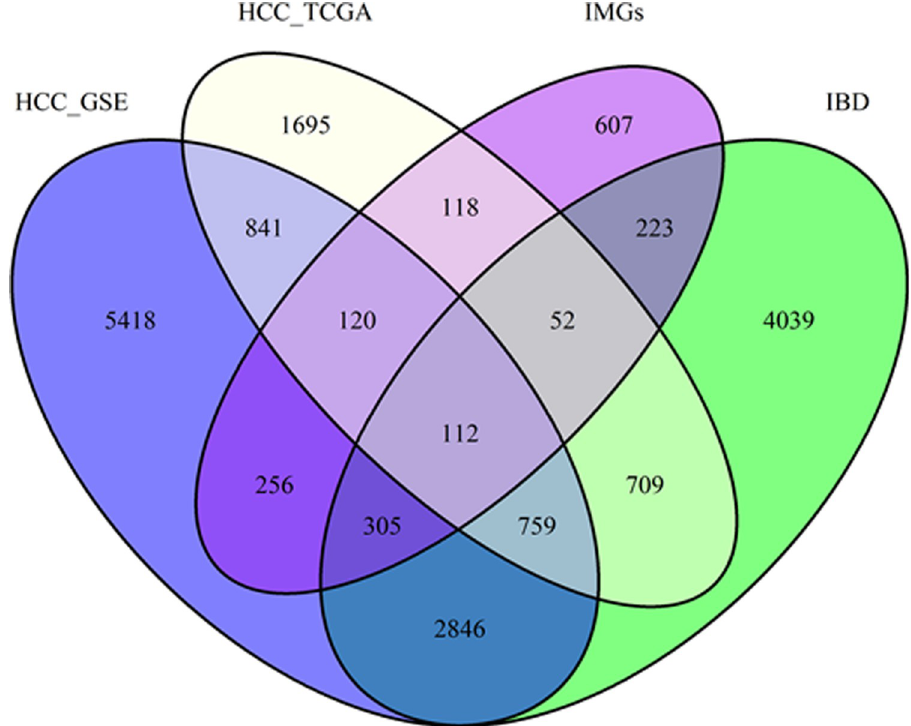
Fig 2. The Venn diagram for visualization of immune-related differentially expressed genes found in IBD, HCC. The value represented the number of unique gene symbols covered from the ensemble IDs and probe IDs. IBD, Inflammatory bowel disease; HCC, Hepatocellular carcinoma; IMGs, immune genes; TCGA, The Cancer Genome Atlas.